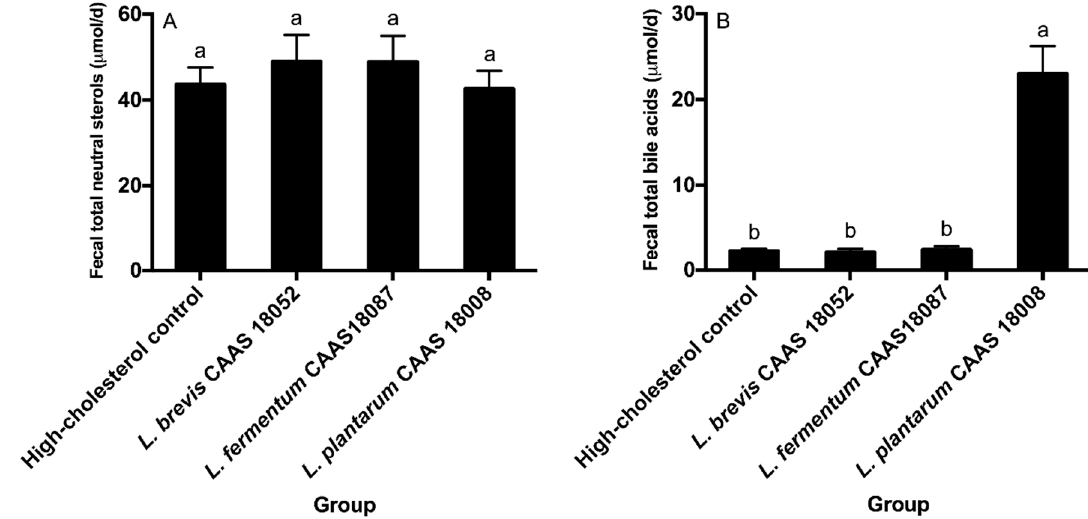
Figure 5. Daily excretion levels of fecal total neutral sterols ( A ) and total bile acids ( B ) of the different groups. Data are represented as the mean ± SD ( n = 8). Means not sharing a common letter differ significantly ( p < 0.05).